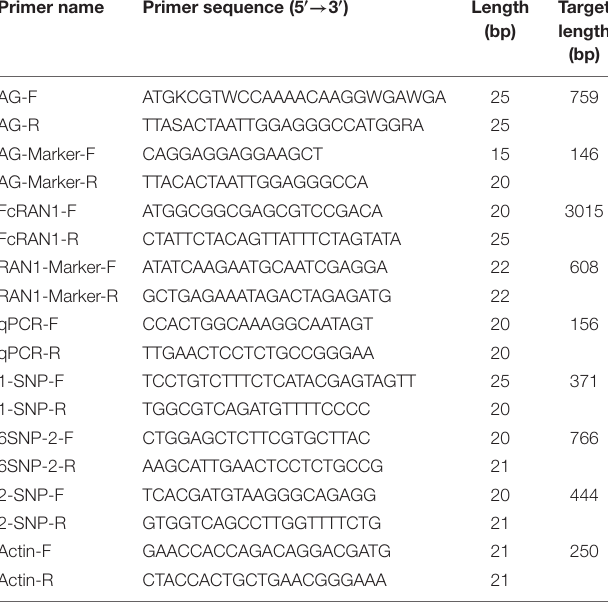
TABLE 1 | Primers used in this study.